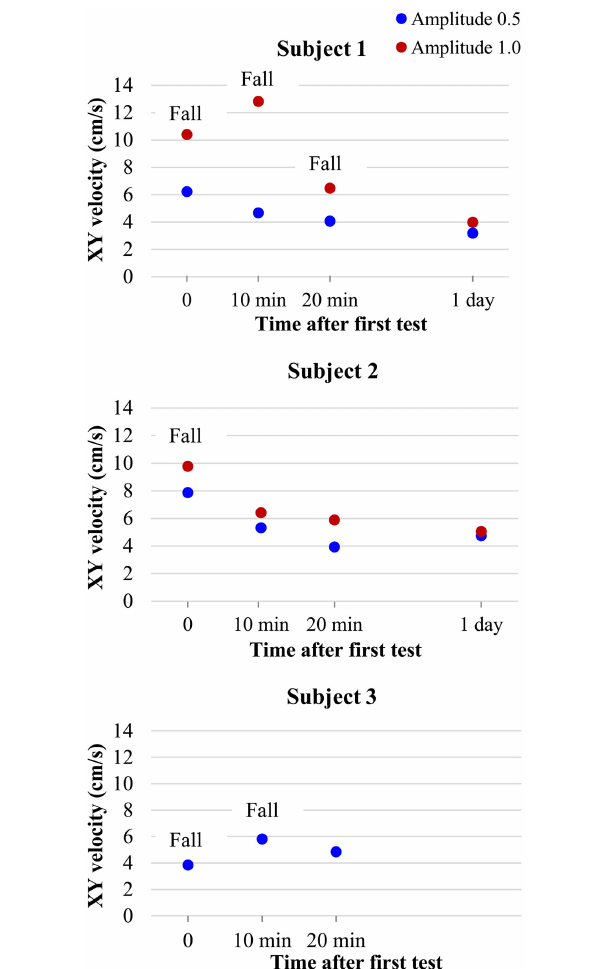
FIGURE 7 | Balance results of subjects tested on WBB + f with VR visual distraction at amplitudes of 0.5 (blue circles) and 1.0 (red circles) during continuous stimulation on WBB + f at several times (10, 20min), during the habituation period and 1day after .